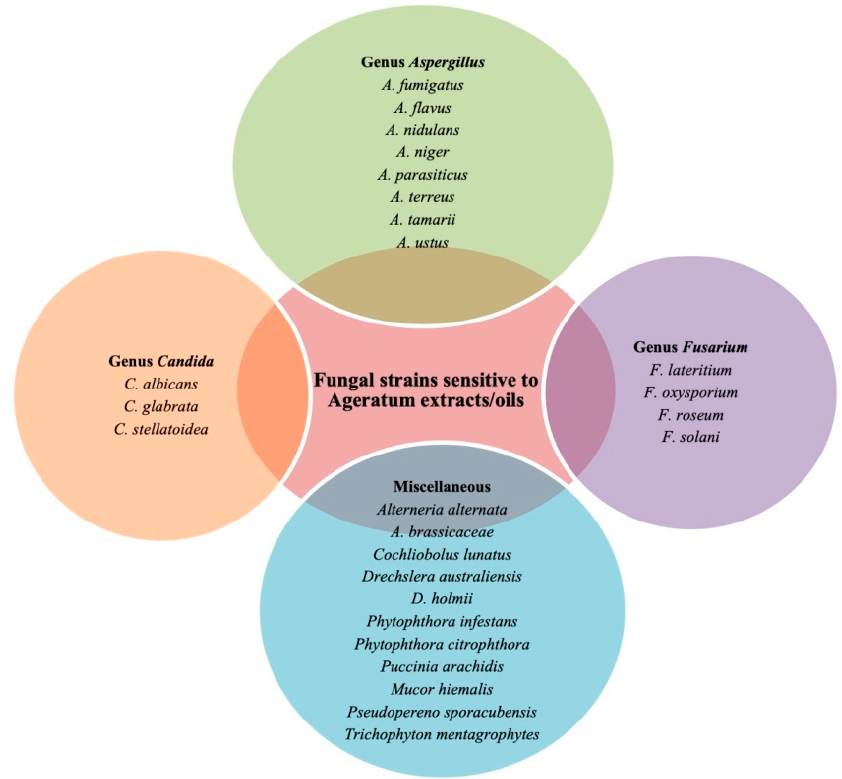
Figure 3. Various pathogenic fungal strains sensitive to Ageratum extracts/oils.